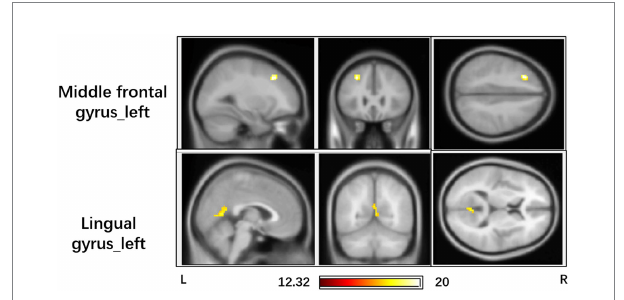
FIGURE 1 Brain regions with significant interaction effect (GRF corrected, p < 0.05, the initial height threshold is p < 0.001).